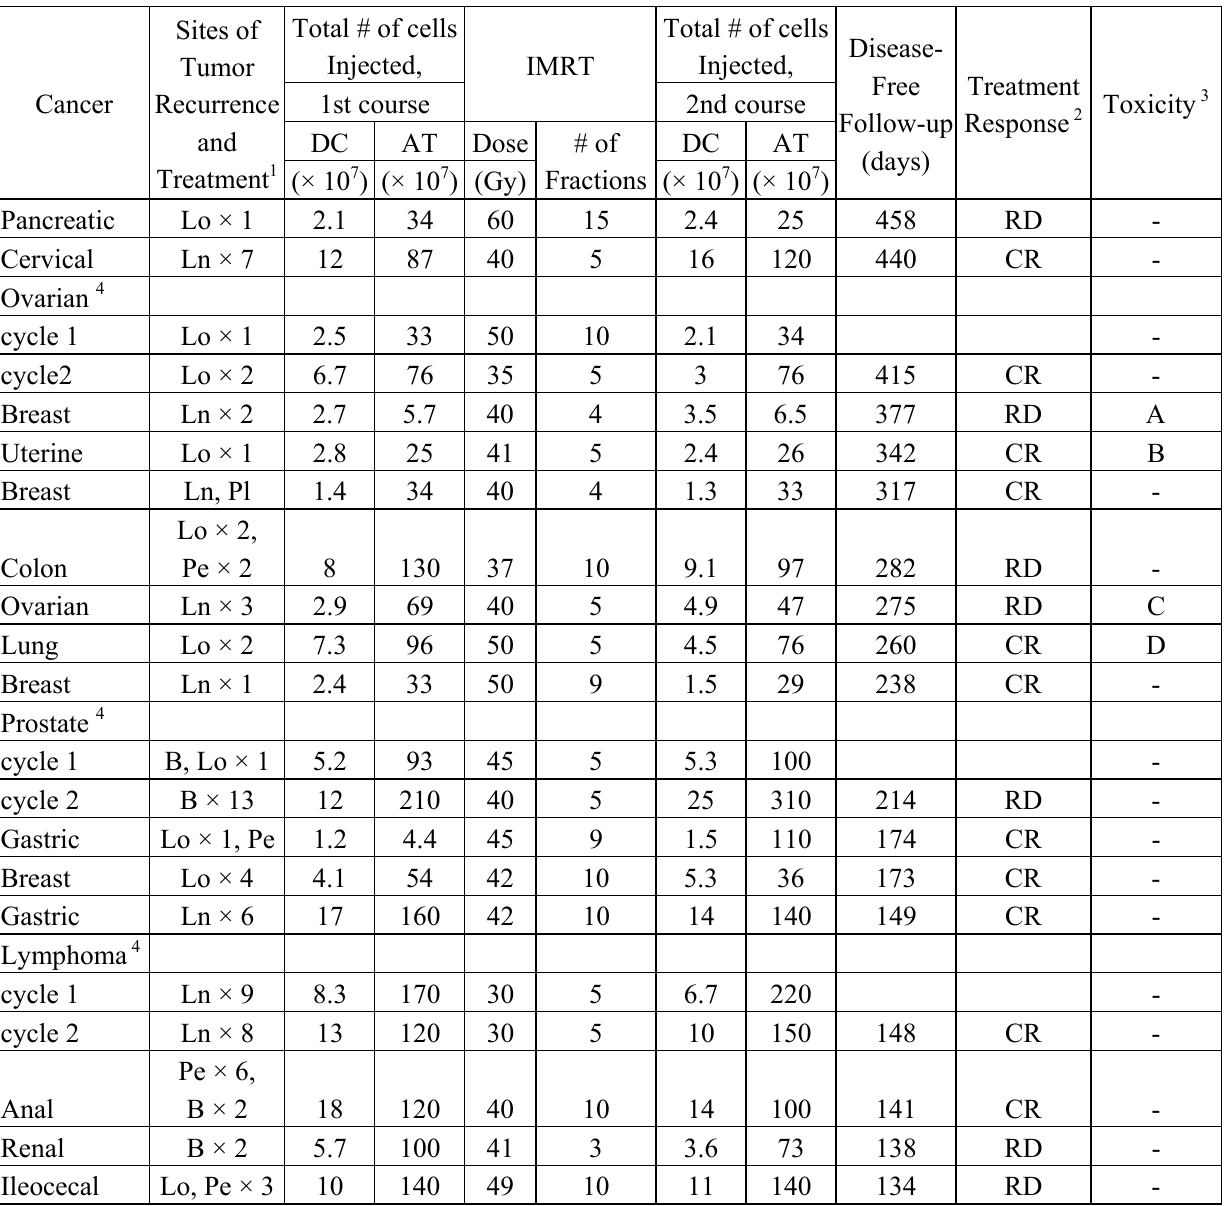
Table 3. Treatment and clinical